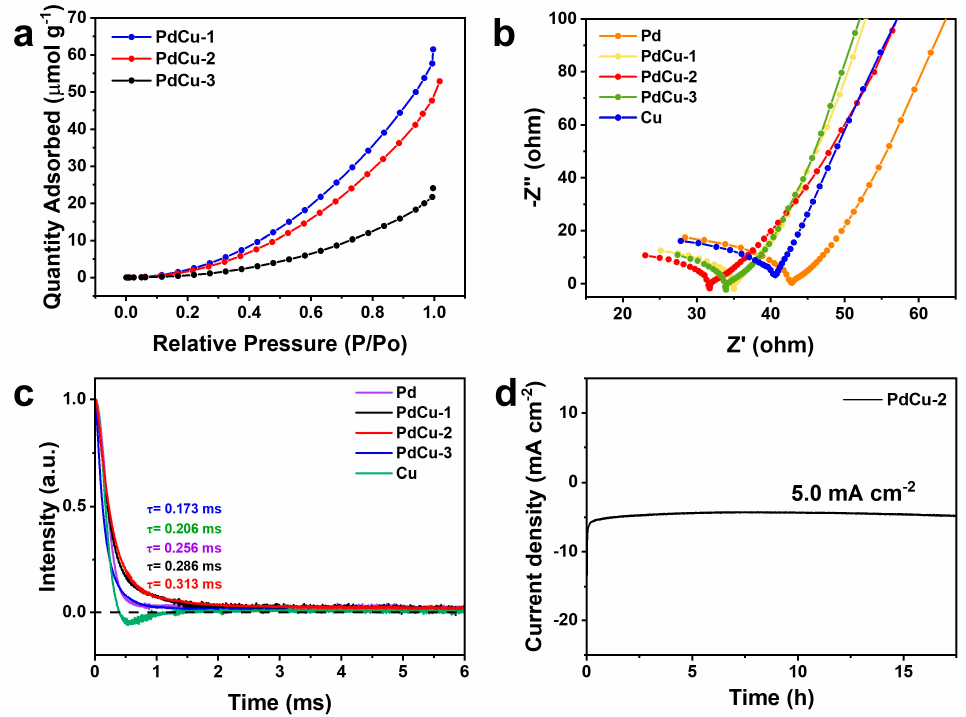
Figure 4. ( a ) The CO 2 adsorption isotherms of PdCu − 1, PdCu − 2, and PdCu − 3; ( b ) EIS spectra of Pd, PdCu − 1, PdCu − 2, PdCu − 3, and Cu; ( c ) TPV curves of Pd, PdCu − 1, PdCu − 2, PdCu − 3, and Cu; ( d ) the stability test of PdCu − 2 at the potential of − 0.9 V (vs. RHE) for 17 h.